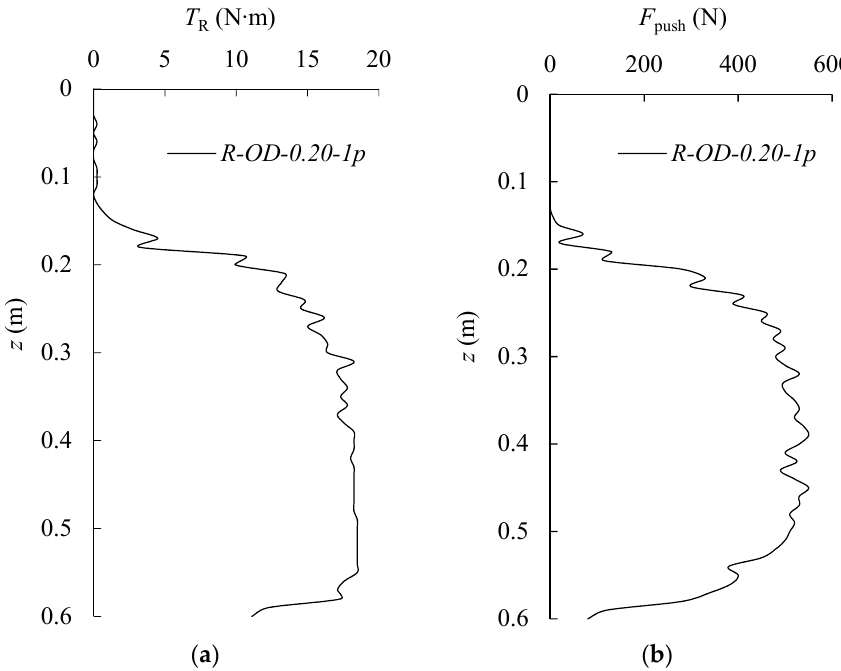
Figure 8. The test results of TN-3. ( a ) Recycling torque. ( b ) Vertical force on shaft.